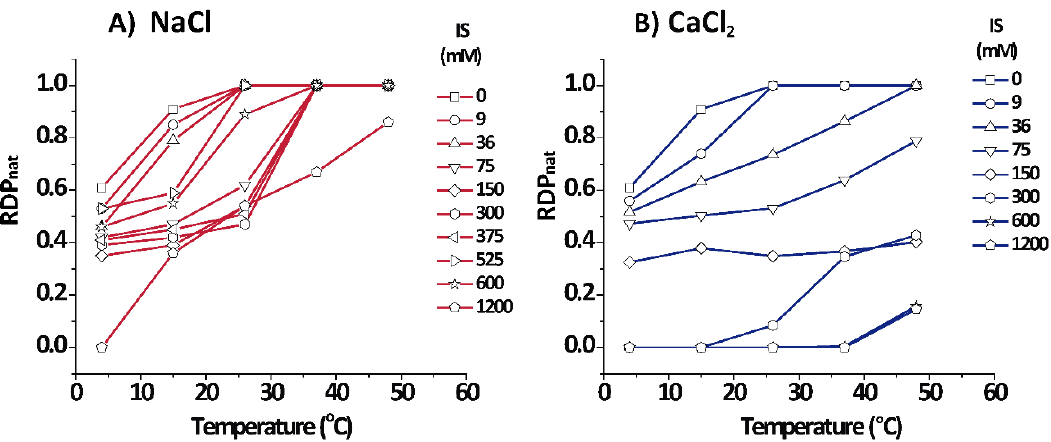
Figure 4. Relative diffracting power ( 𝑅𝐷𝑃 (cid:3041)(cid:3028)(cid:3047) ) of the native phase as a function of temperature and IS. Data for PMMs in aqueous salt solutions based on NaCl and CaCl 2 are shown in panels ( A ) and ( B ), respectively.